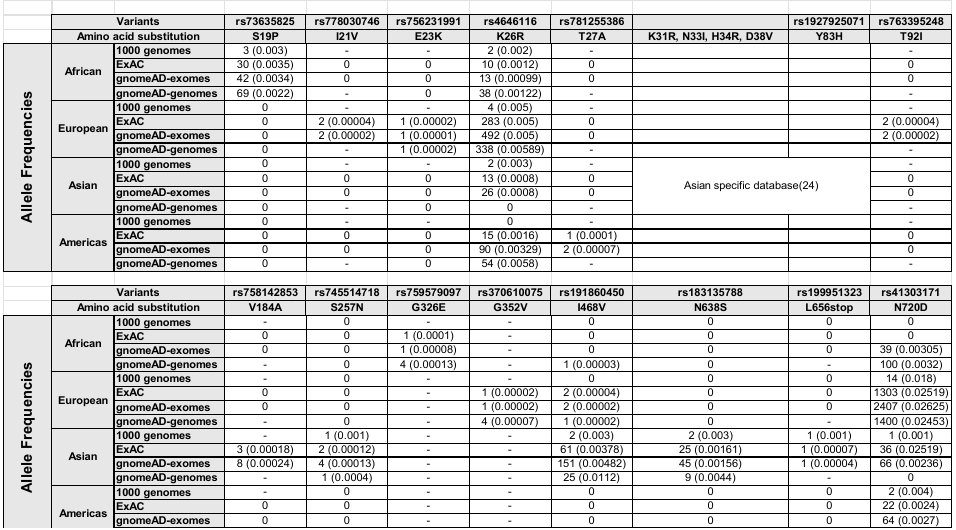
Table 1. ACE2 polymorphisms found in different populations.